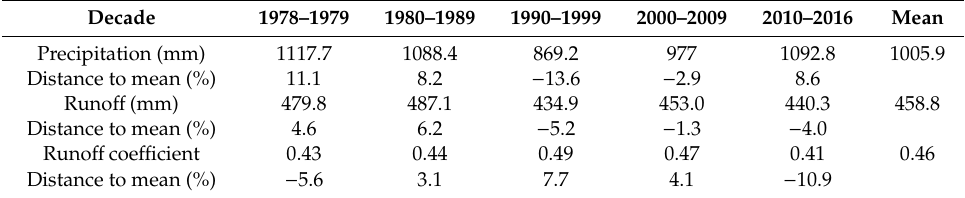
Table 1. Summaries of precipitation and runo ff in di ff erent decades.